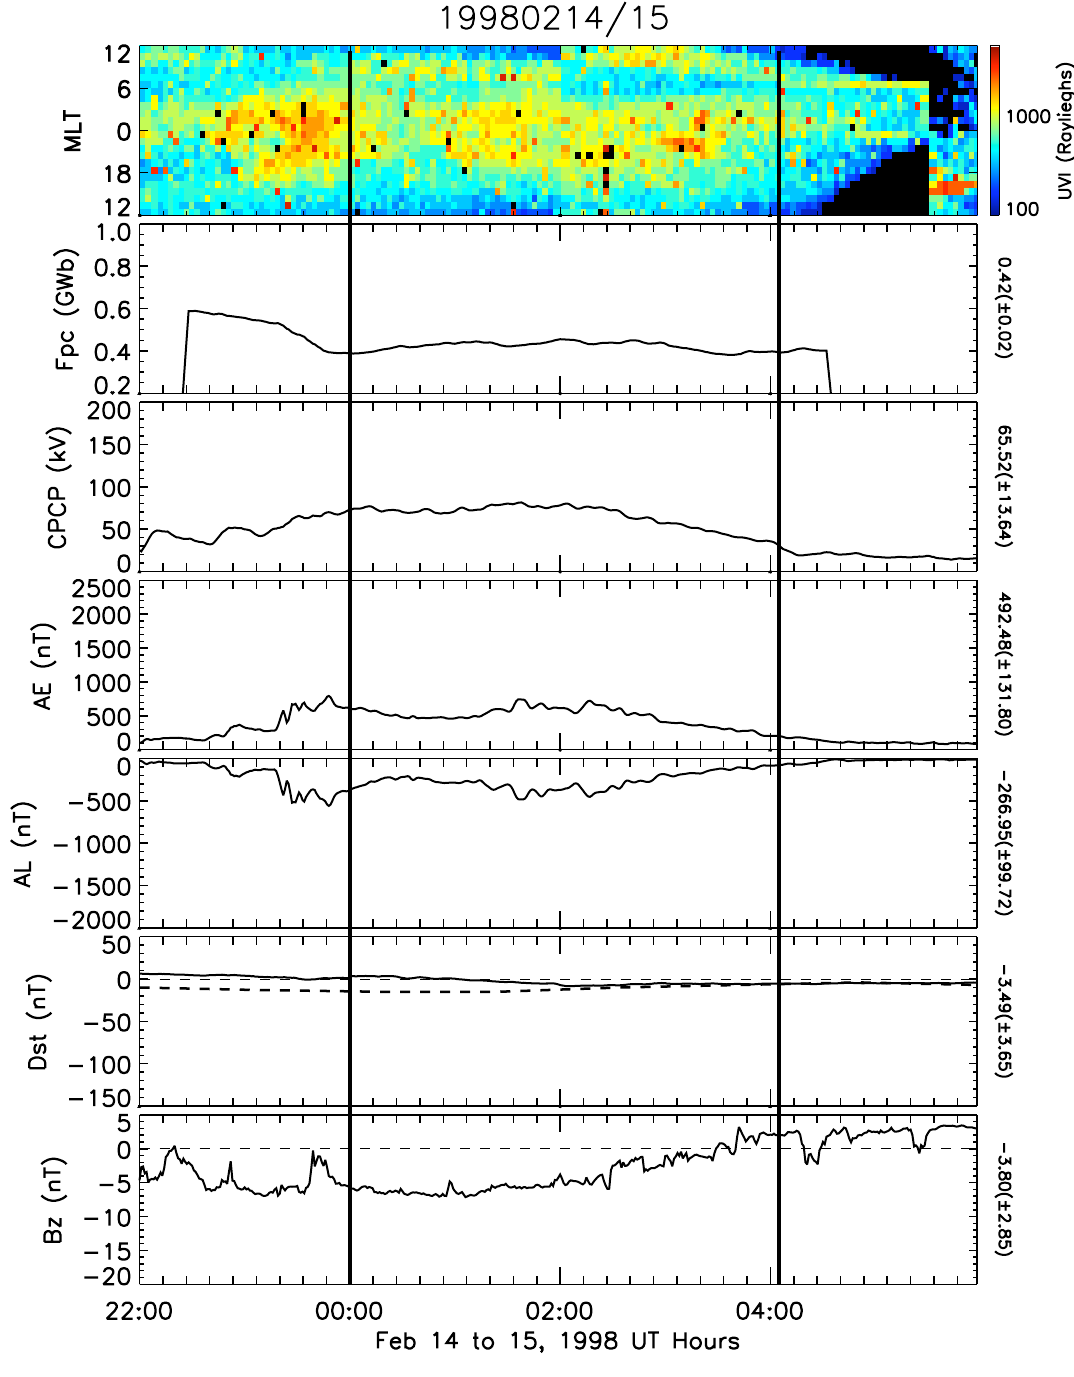
Fig. 4. A stack plot of the data for the BRI on 14 and 15 February 1998 (Event 2). The set up is the same as Fig. 1.